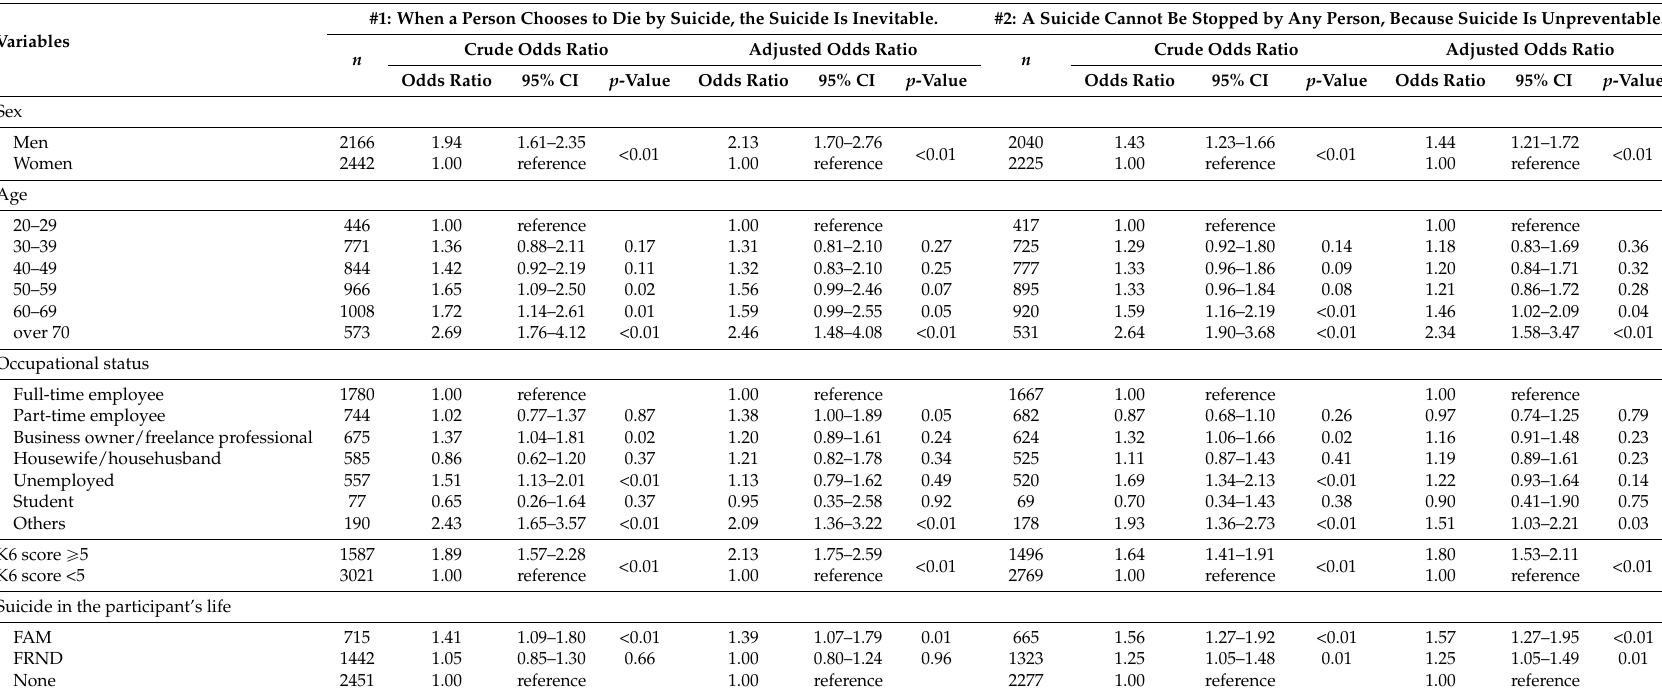
Table 2. Relationships of attitudes #1 and #2 toward suicide with depressive symptoms and sociodemographic characteristics, by the logistic regression analysis.